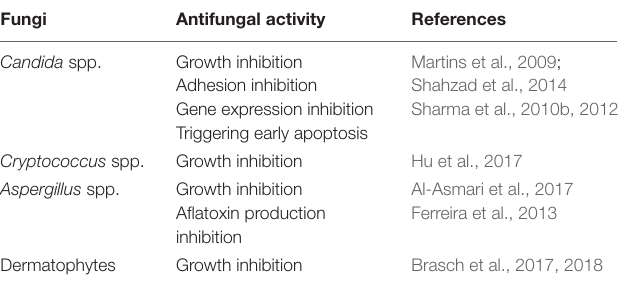
TABLE 3 | Antifungal activity of